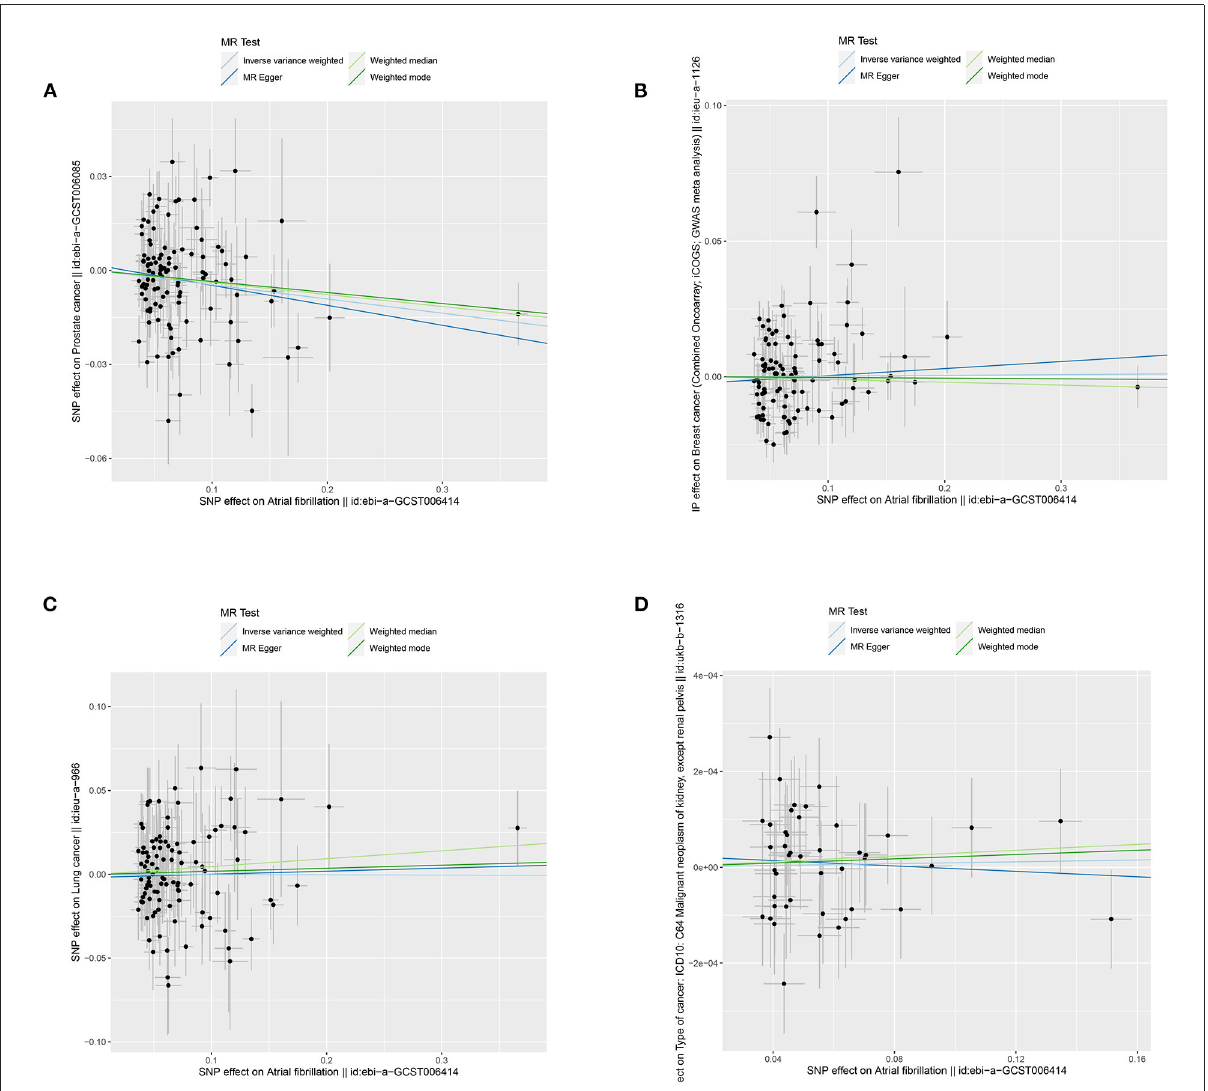
FIGURE2 Scatterplots for MR analyses of the causal effect of atrial fibrillation on cancer risks: (A) prostate cancer; (B) breast cancer; (C) lung cancer; and (D) kidney cancer. The x-axis represents the previously published β -estimate for the association of each SNP with atrial fibrillation. The y-axis outlines the β -estimate for the relationship of each SNP with cancer risks by means of the multivariate logistic regression model. Lines represent causal estimates from the different methods. The slope of each line indicates the estimated MR effect per method. Circles correspond to marginal genetic associations with atrial fibrillation and risk of outcome for each variant. Error bars indicate 95% confidence intervals. SD, standard error; MR, Mendelian